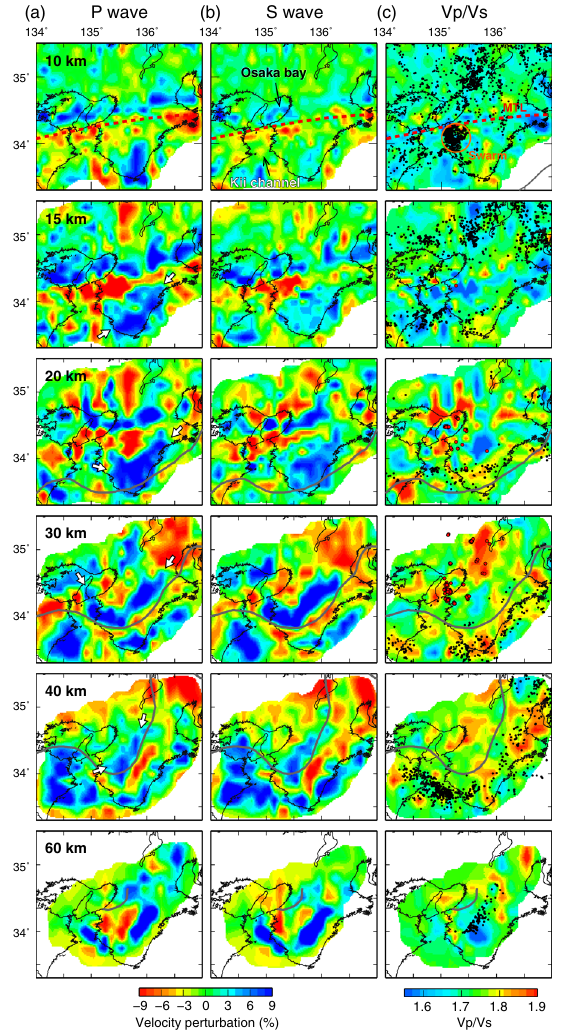
Fig. 9 a P-wave and b S-wave velocity perturbations and c V p / V s ratios at 10, 15, 20, 30, 40, and 60 km depth. Velocity perturbations are the deviations from the average velocity at each depth. Gray curves represent the iso-depth contour of the PHS slab at each depth. Regions with a deviated weight sum of > 1000 are shown. Hypocenter (black dots) and LFE (red circles) distributions are shown in ( c ) (note that tectonic LFEs are not shown). White arrows at 15–40 km depth in ( a ) denote the high-velocity zone discussed